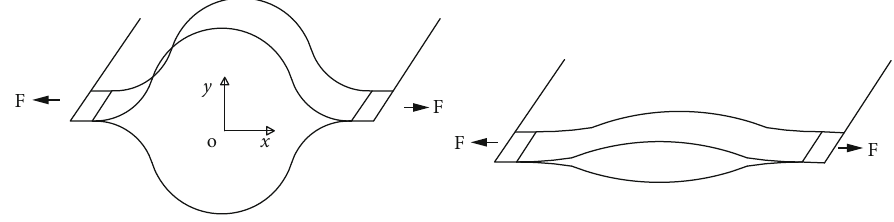
Figure 5: Pull fl attening process of lenticular